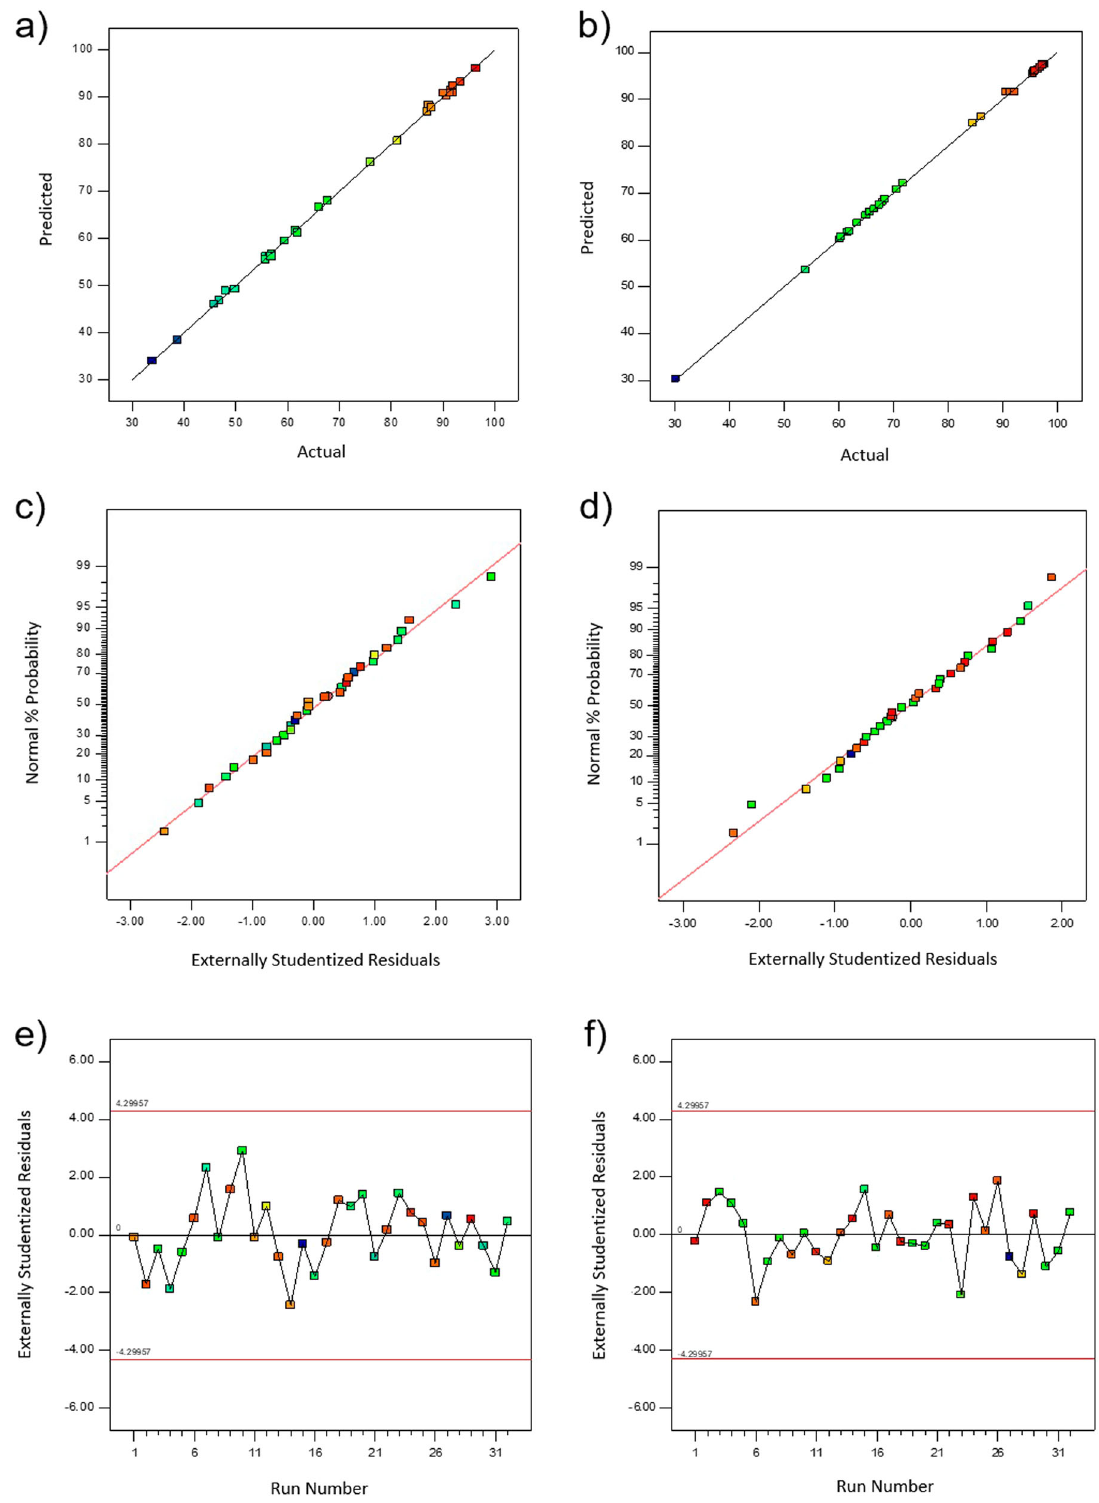
Fig. 4 Residuals of plots. a , b The experimental data versus predicted data for extraction of RB and MG, c , d normal plot of residuals forextraction of RB and MG, e , f residuals versus runs for extraction of RB and MG (Model Statistics: Quadratic, Degrees of freedom: 20, Sum of squares (RB): 11707.52, Sum of squares (MG): 9205.77, Adj- R2 (RB): 99.73%, Adj- R2 (MG): 99.74%, Adeq-Precision (RB): 94.160, Adeq-Precision